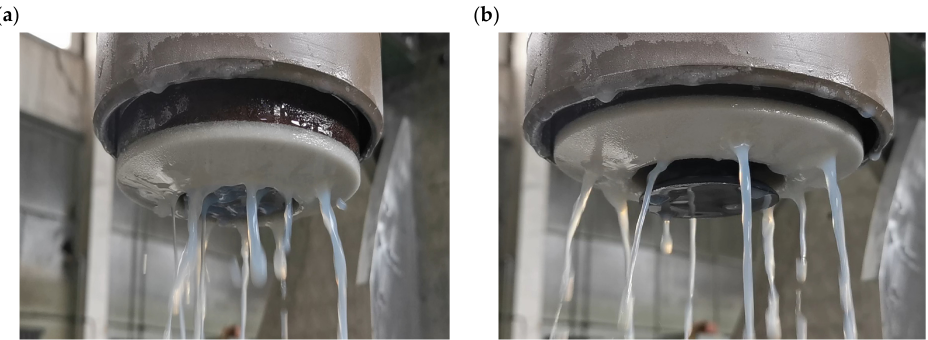
Figure 8. A dual-tool grinding head prepared for the cutting process with coolant supply in the position for: ( a ) coarse grinding; ( b ) finish grinding.